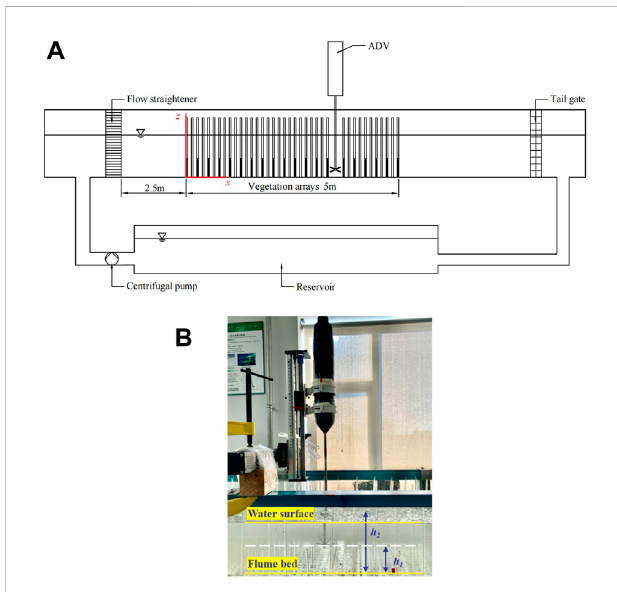
FIGURE 2 Experimental arrangement: (A) Sketch of the laboratory recirculating fl ume setup, the black part of the vegetation section representstheshortcylinder; (B) AphotooftheexperimentforrunXHS1, where short cylinders ( h 1 ) are submerged and tall cylinders ( h 2 ) are